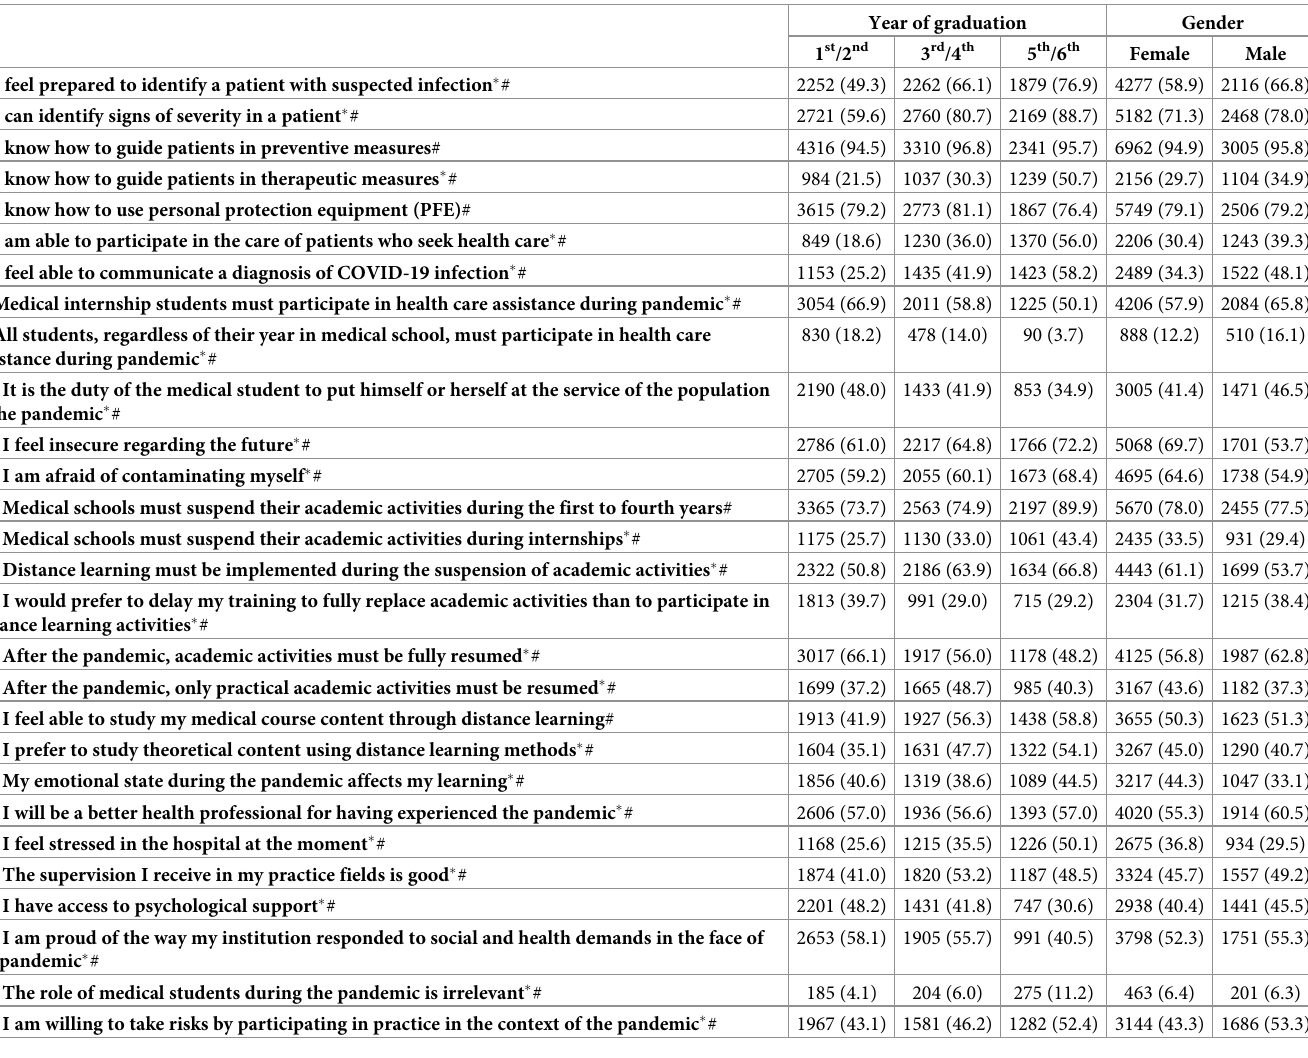
Table 2. Students’ perceptions according to year in medical school and sex during the COVID-19 pandemic—The number of students who responded “totally agree” or “agree” (% of